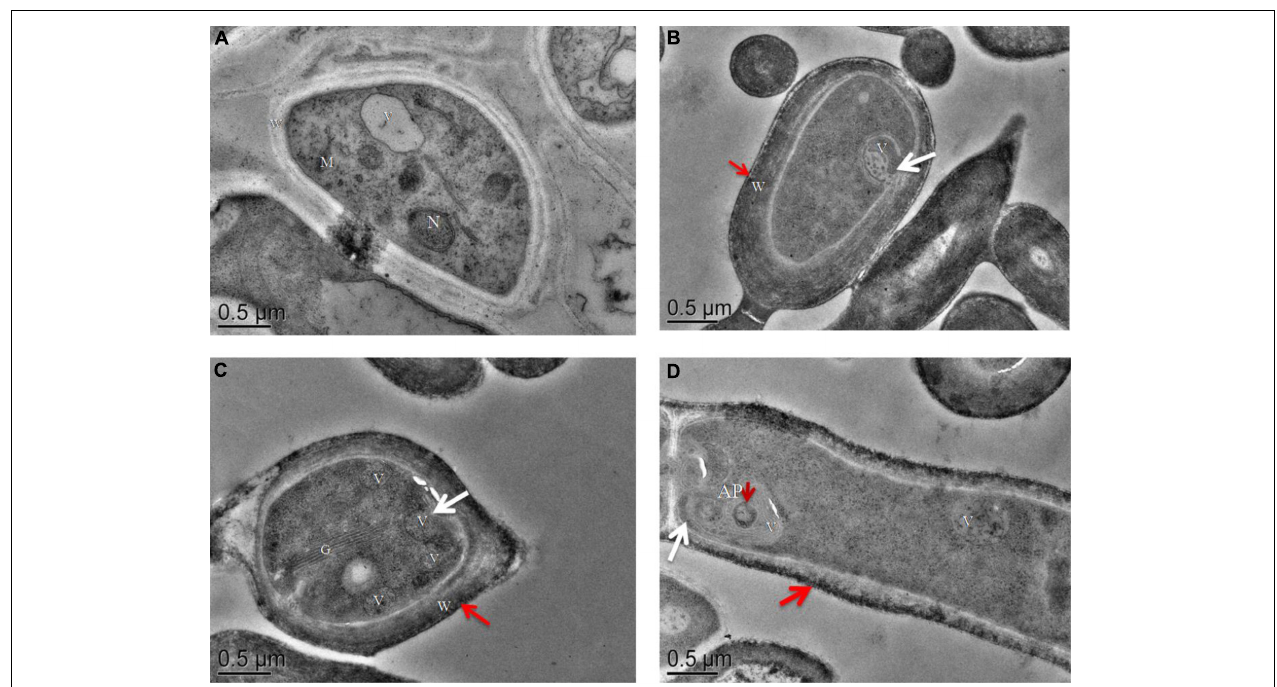
FIGURE 7 | Transmission electron microscopy images of ultrathin sections of cultures of (A) mycelia without brown film (BF) (30 days) and (B–D) mycelia with BF: (B) 45 days, (C) 60 days, and (D) 75 days. In mycelia with BF, the plasma membrane appears to shrink from the cell wall [ (B–D) , white arrows]. Autophagosomes (AP) containing recycling components [ (D) , short red arrow] and a cell wall pigment layer [ (B–D) , long red arrow] are indicated. N, nucleus; M, mitochondrion; V, vacuole; W, cell wall; G, Golgi. Scale bars = 0.5 µ